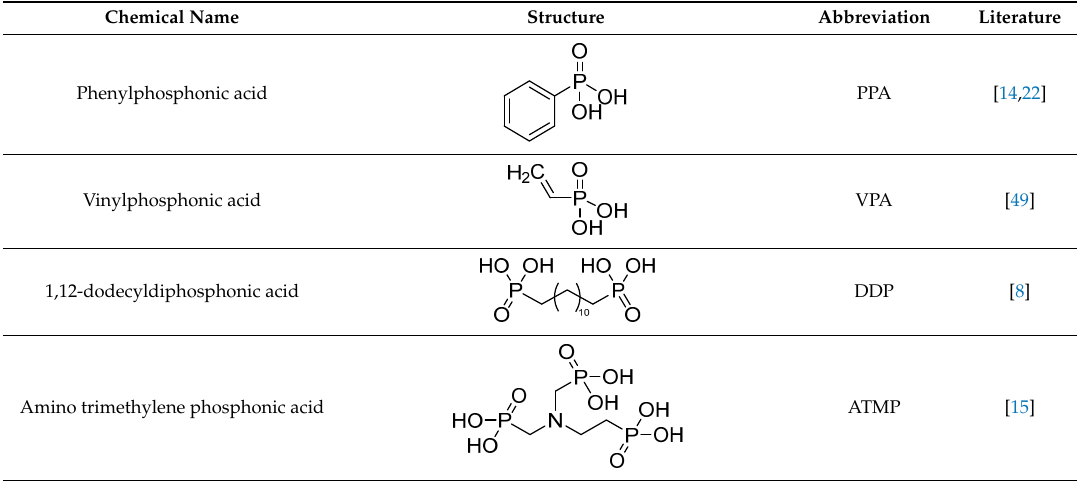
Table 5. Chemical name, structure, and abbreviation of organophosphonic acids.